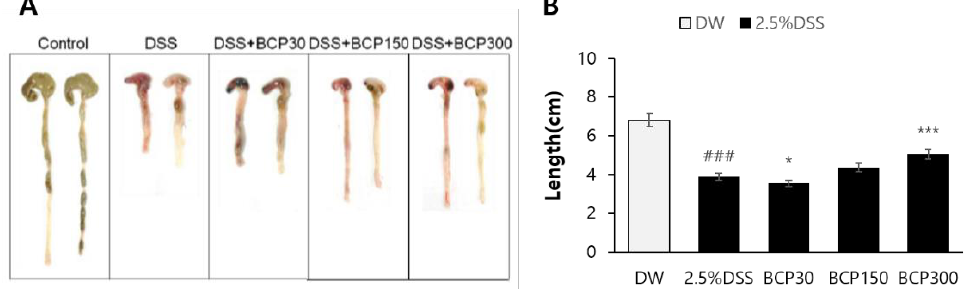
Figure 3. The effect of BCP on the length of the colon in a DSS-induced colitis mouse model. After collecting the colon, its length was measured from the proximal colon to the distal colon. Data are presented as mean ± SEM. Group comparisons were performed using unpaired t -test with post-test (###, p < 0.001, compared to vehicle-treated control mouse) (*, p < 0.05; ***, p < 0.001, compared to vehicle-treated, DSS-induced colitis mouse).